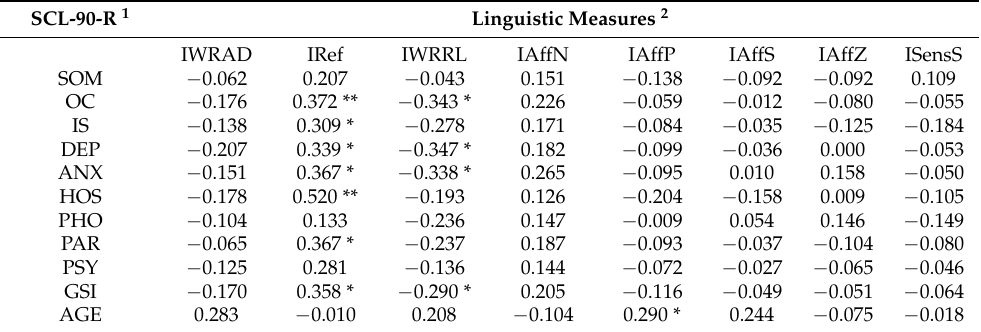
Table 2. Pearson’s correlations between SCL-90-R, age, and linguistic measures of RA (N = 48). SCL-90-R 1 Linguistic Measures 2